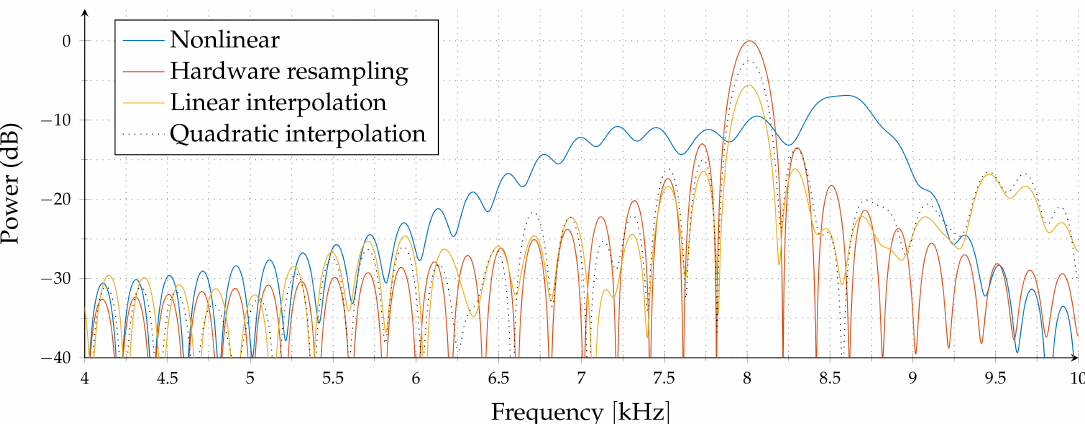
Figure 3. Spectral comparison of hardware time resampling ( red ), software time resampling with f ADC = 20kHz ( orange / dotted ), and uncorrected nonlinear VCO ( blue